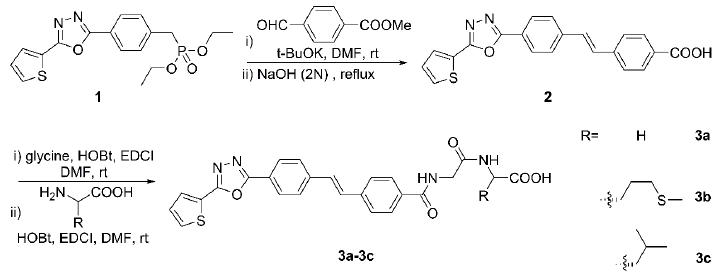
Figure 1. Synthetic route for the target molecules 3a – 3c .